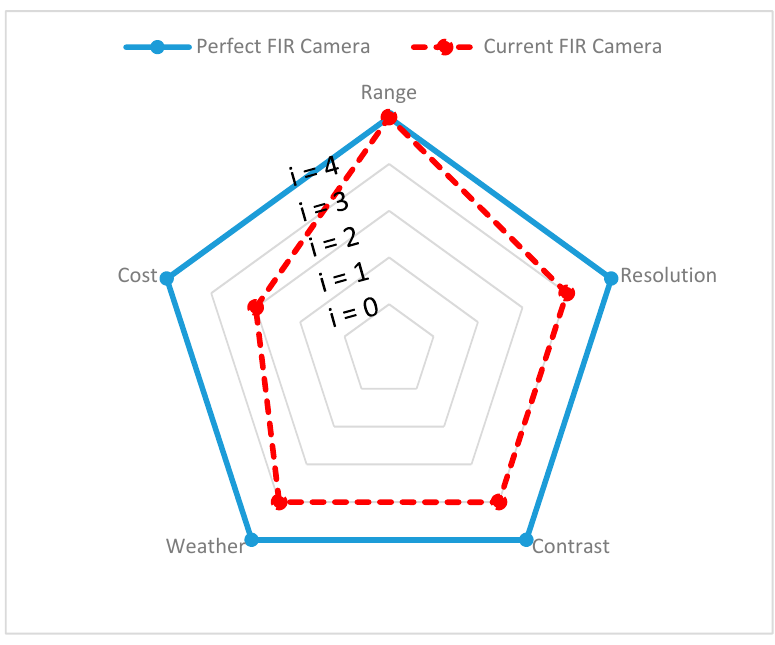
Figure 11. Far-infrared sensor spider chart. The difference between the red dashed line and the solid blue line is the performance gap.